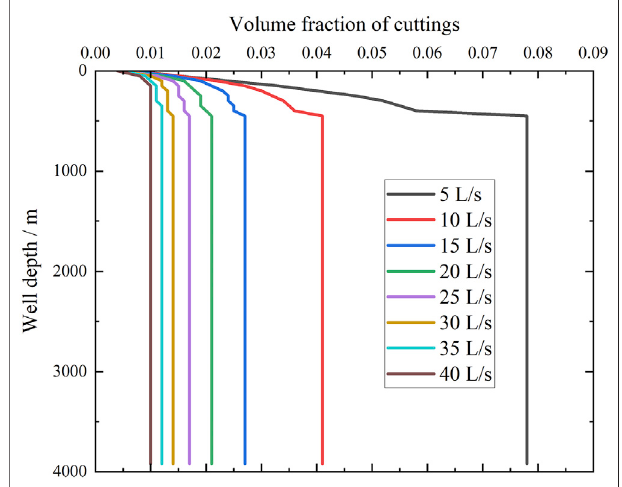
FIGURE 3 | Effect of drilling fl uid displacement on the pressure in the return pipeline.